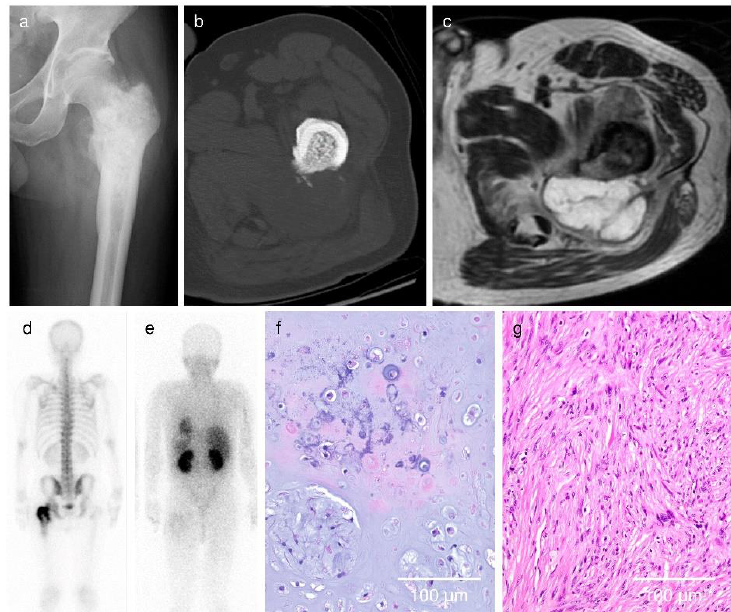
Figure 5. Case 3. A 58-year-old man showed a periosteal reaction on X-ray ( a ); endosteal scalloping and cortical defect on CT ( b ); and extraskeletal mass, multilobular mass, and abnormal signal intensity in adjacent soft tissue and bone marrow on MRI ( c ). Increased uptake greater than the anterior iliac crest on the bone scan and 201 Tl scan were also seen ( d , e ). Based on the findings, the overall radiological score rate was calculated as follows: [1 point (X-ray) + 3 points (CT) + 8 points (MRI) + 2 points (bone scan) + 2 points ( 201 Tl scan)]/16 points (full marks) = 100% ( f , g ) The microscopic image showed bimorphic appearance of grade 1 – 2 chondrosarcoma and fibrosarcoma components. The final histological diagnosis of the tumor was dedifferentiated chondrosarcoma.